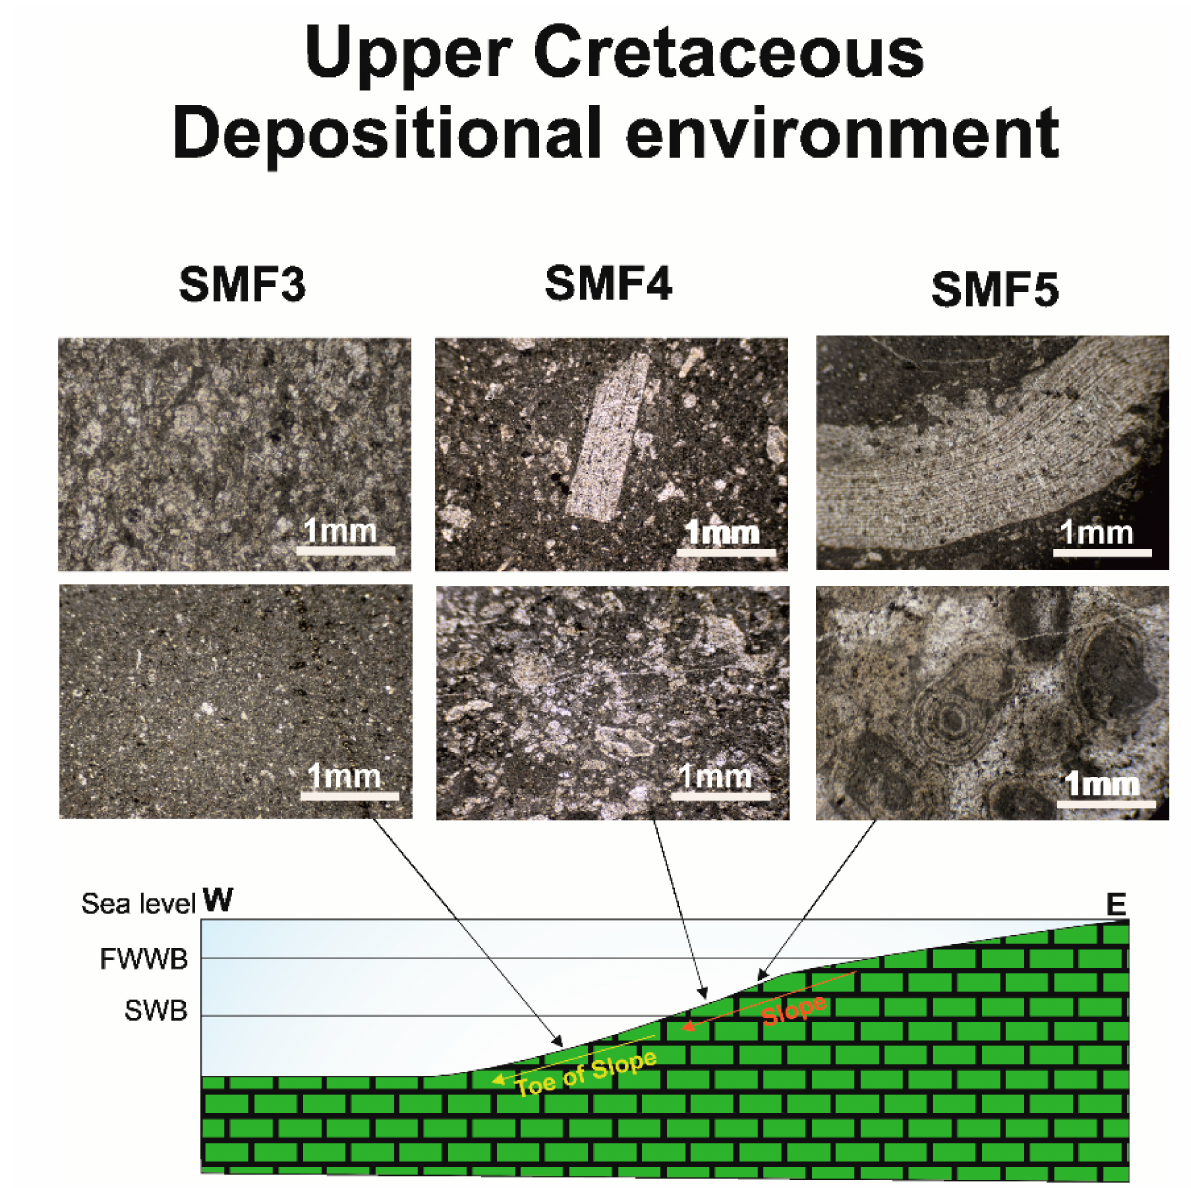
Figure 23. Microfacies types and the corresponding depositional environments/Facies Zones during the